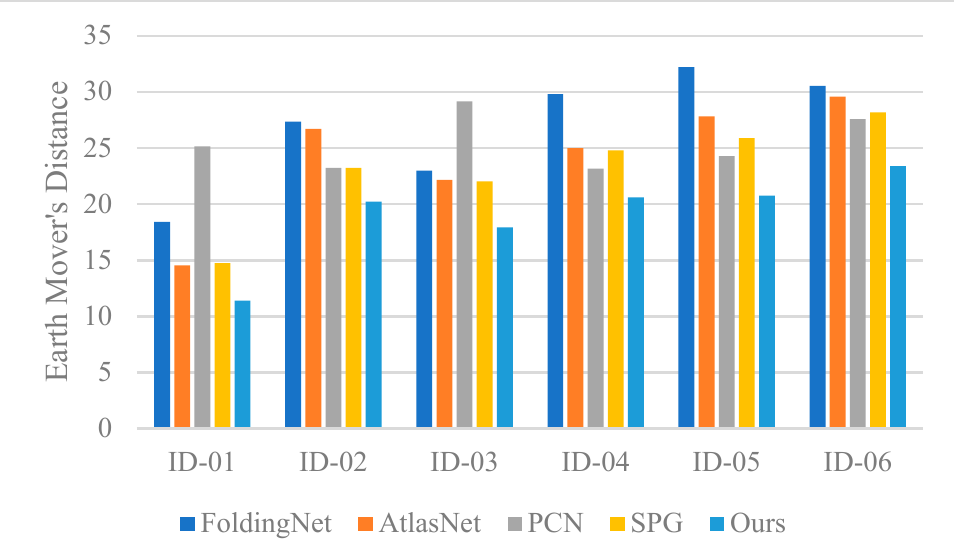
Figure 8. EMD distance after point cloud completion of different models.